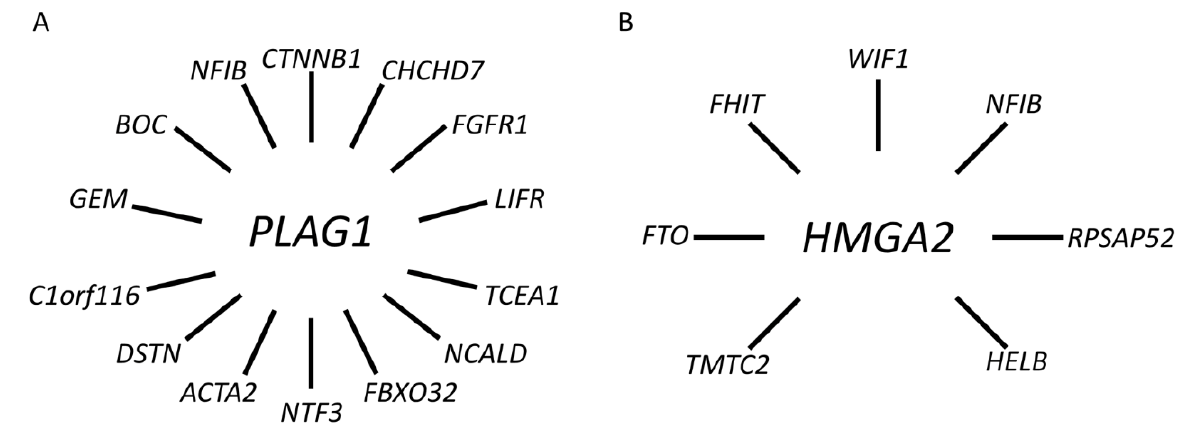
Figure 4. Gene fusion network in PA . ( A ) PLAG1 and its 14 known fusion partner genes. ( B ) HMGA2 and its seven known fusion partner genes.